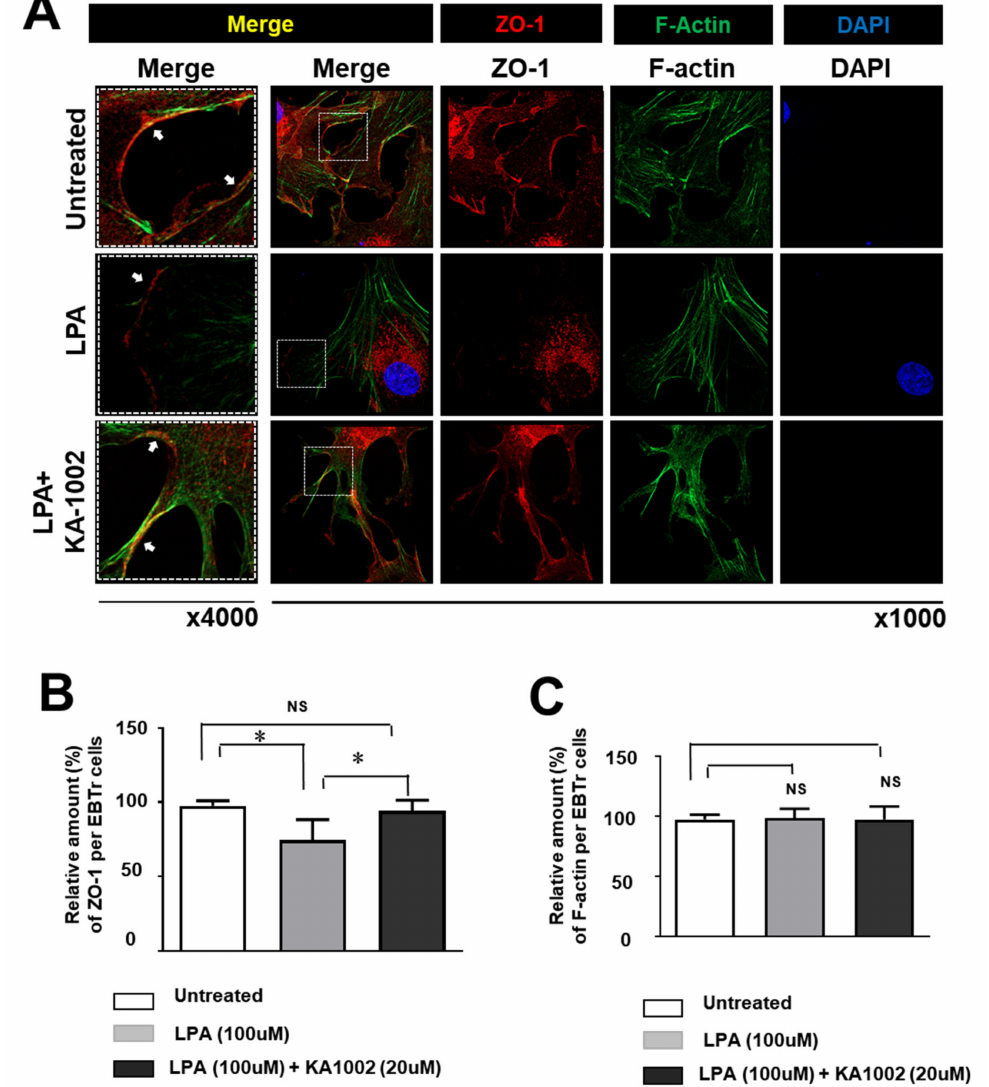
Figure 3. ( A ) EBTr cells were treated with 100 µ M LPA or 100 µ M LPA + 20 µ M KA-1002 for 18 hours. Representative images of ZO-1 expression in each group were obtained using confocal microscopy, with ZO-1 shown in red, F-actin stained with phalloidin in green, and nuclei stained with DAPI in